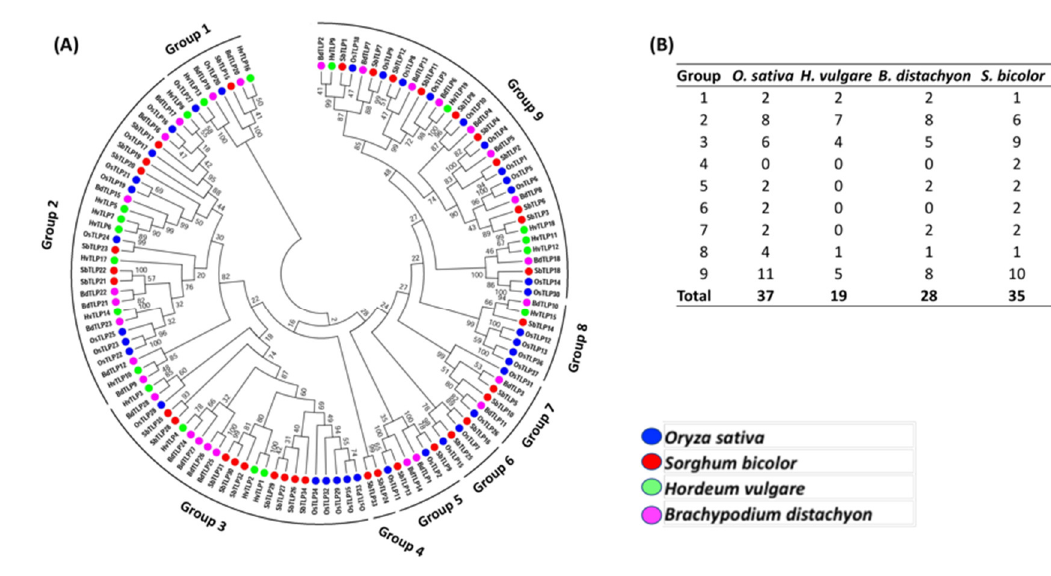
Figure 2. ( A ) Phylogenetic analysis of TLP protein family among cereals . The TLP domain was identified and the phylogenetic tree was constructed using a neighbor-joining method with 1000 bootstraps. Terminal tree markers are indicative of species (barley, bright green; rice, blue; sorghum, red; Brachypodium , pink). ( B ) Group wise distribution of cereal TLPs in the phylogenetic